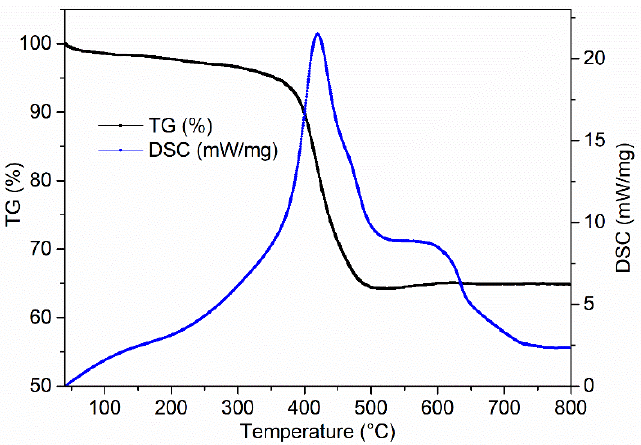
Figure 7. TG–DSC curve of CF/SrTiO 3 /CdS.